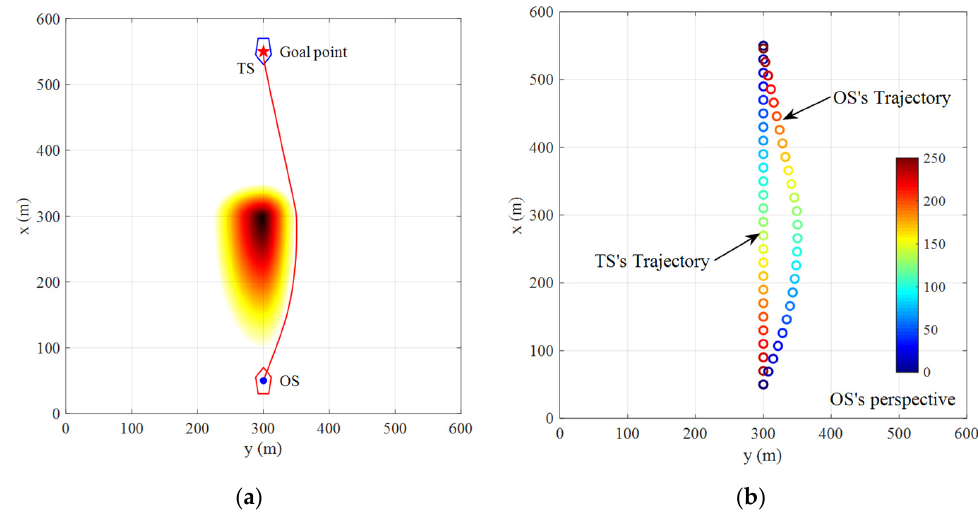
Figure 6. The path planning results and the collision avoidance trajectories in the head-on scenario. ( a ) The path planning results, ( b ) The collision avoidance trajectories.